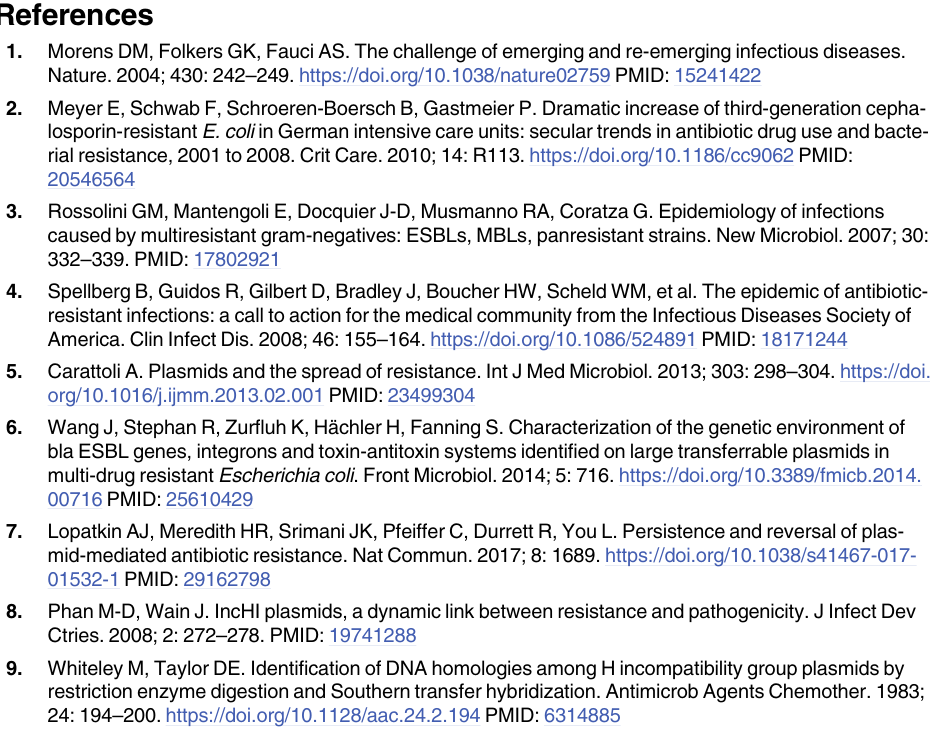
S2 Table. Bacterial strains and plasmids used in this work. S3 Table. Oligonucleotides used in this